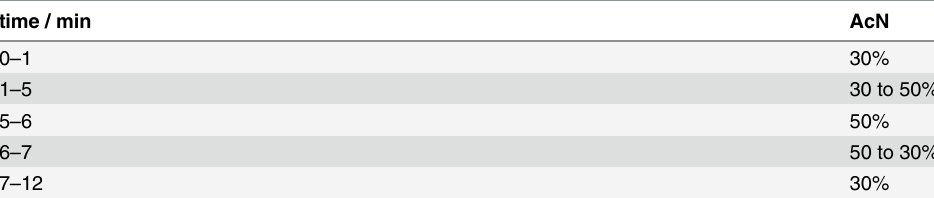
Table 3. Gradient used during HPLC